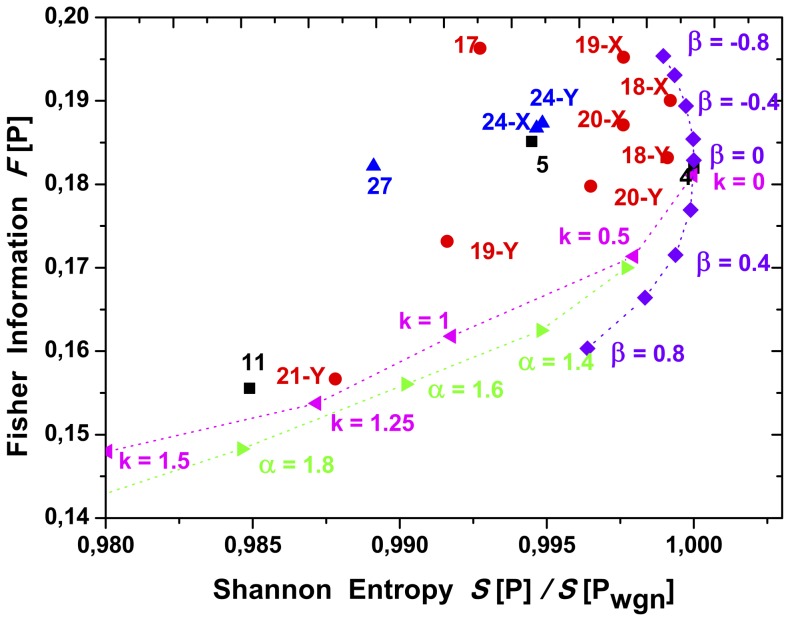
Shannon-Fisher plane,  zoom, see Fig. 9.